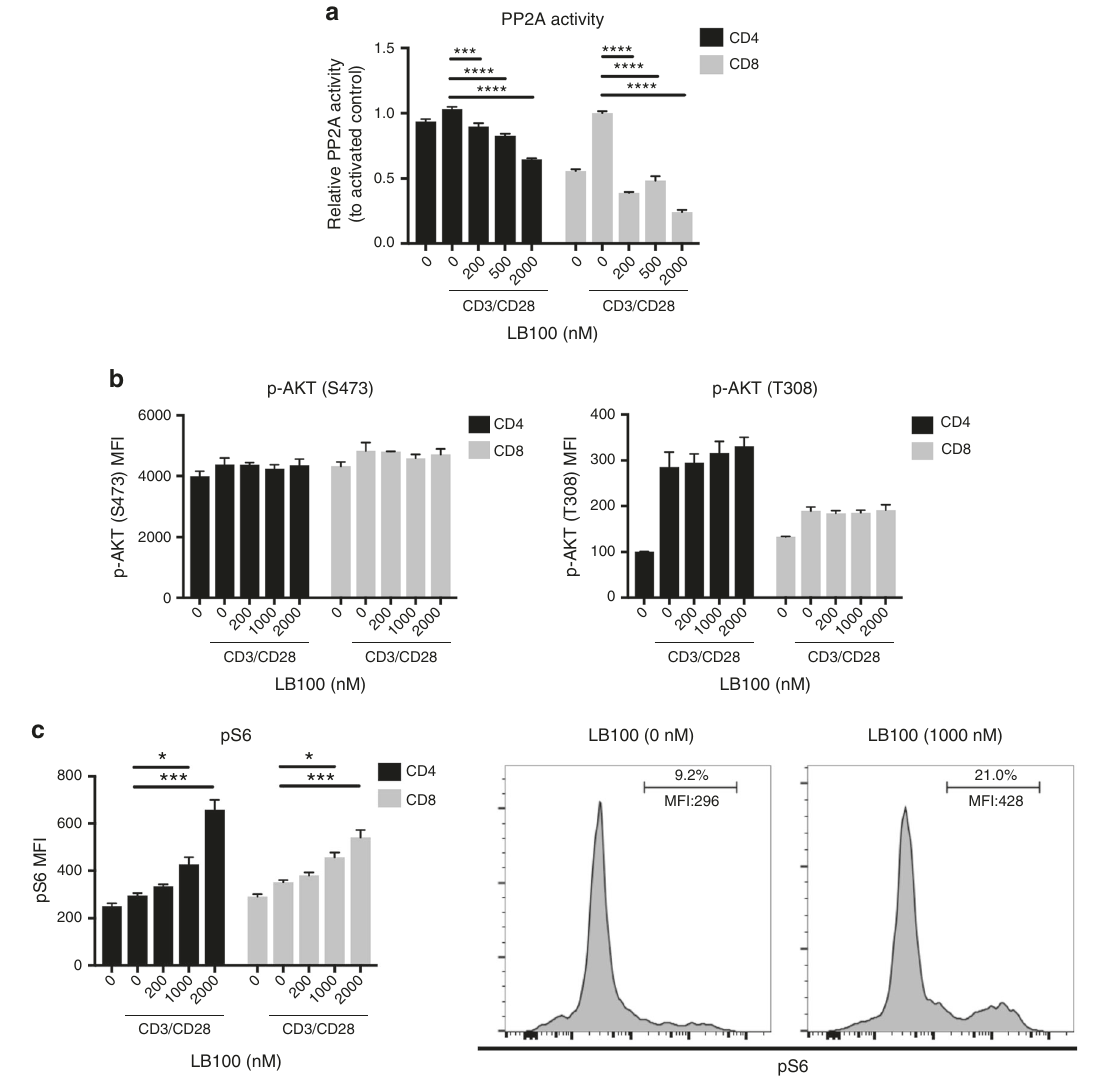
Fig. 6 LB-100 inhibits PP2A enzymatic activity and activates the mTORC1 pathway. CD3 T cells were isolated from mice splenocytes and cultured with or without stimulation using immobilized anti-CD3 (10 μ g ml − 1 ) and soluble anti-CD28 (2 μ g ml − 1 ). a PP2A enzymatic activity was measured after 3 h of activation. PP2A activity was measured as relative to activated control in presence of LB-100 dose titration. b Flow cytometry analyzing AKT phosphorylated at Thr308 (p-AKT(T308)) or Ser473 (p-AKT(S473)) after 3 h of stimulation in presence of LB-100 dose titration. c Flow cytometry analyzing phosphorylated S6 (p-S6) in presence of LB-100 dose titration. * P < 0.05, *** P < 0.001 (one-way ANOVA with Tukey ’ s multiple comparison test). Data are from one experiment representative of two independent experiments with similar results. Error bars depict